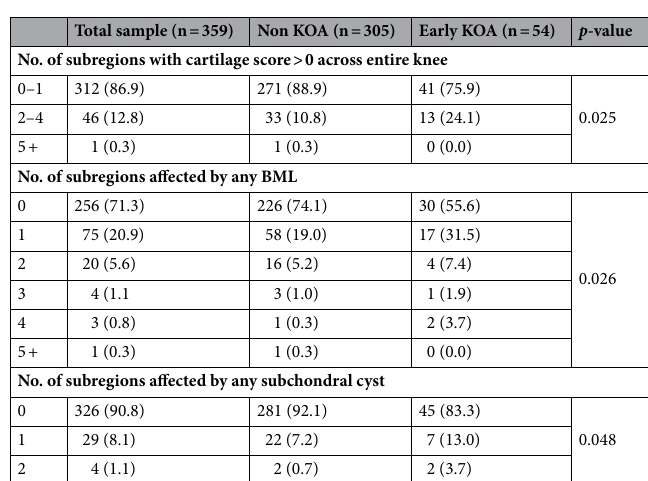
Table 2. The distribution of MRI lesions of study participants. The values represent the number (percentage of the whole population) of MRI lesions of all participants, participants with early KOA, and those without KOA. Differences among the two groups were compared by chi-square test. A p -value indicates the significance of difference between participants with and without early KOA.